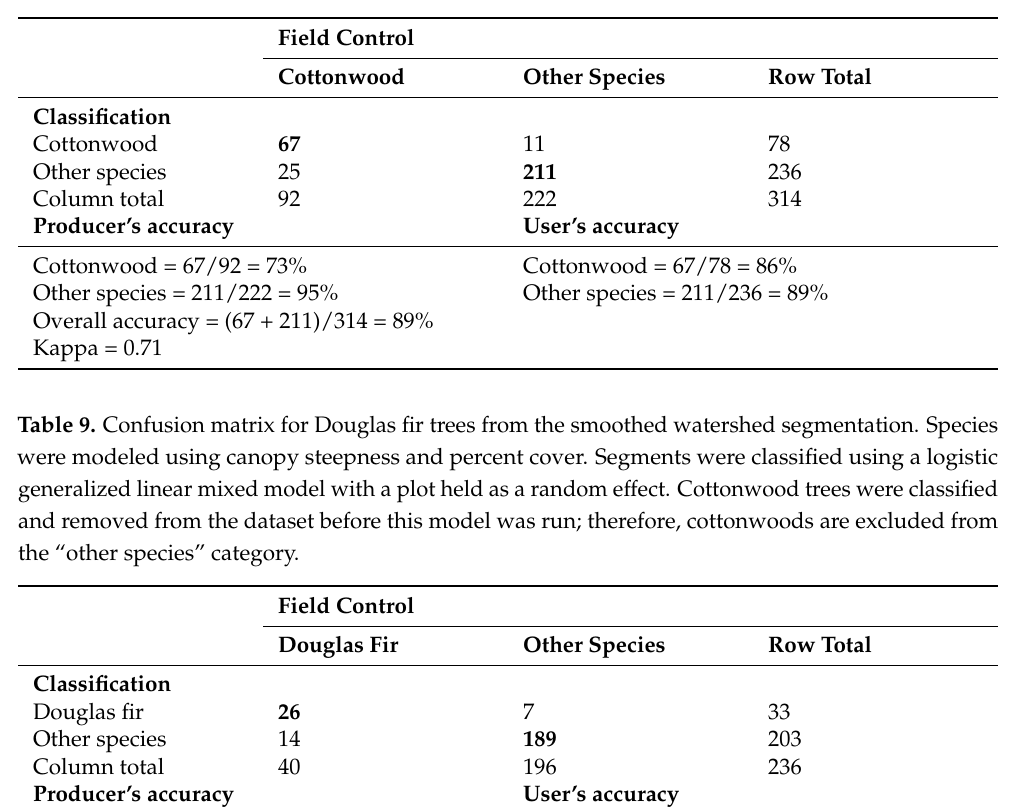
Table 8. Confusion matrix for cottonwood trees from the smoothed watershed segmentation. Species were modeled from canopy steepness and variation in canopy steepness. Segments were classified using a logistic generalized linear mixed model with a plot held as a random effect.